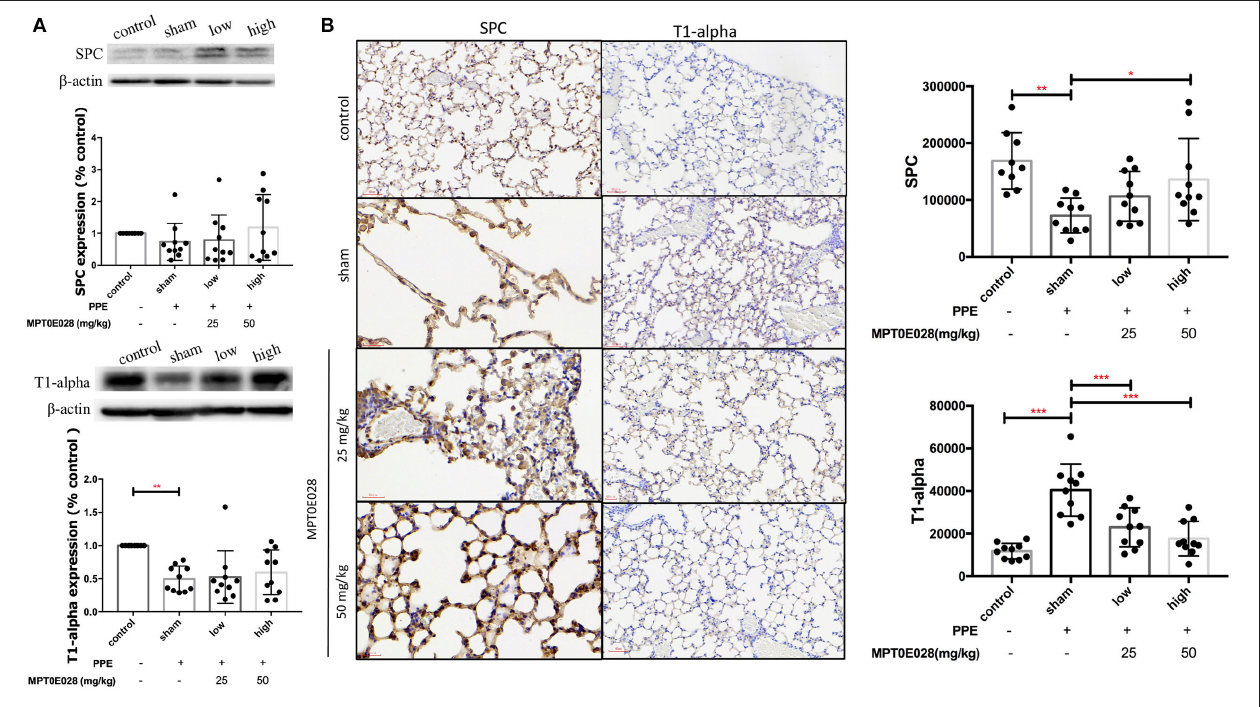
FIGURE 5 | Expressions of surfactant protein C (SPC) and T1 α in the lungs and alveolar region sby the MPT0E028 in mice with porcine pancreatic elastase (PPE)-induced emphysema. (A) Expressions of SPC and T1 α in whole lung lysates by the MPT0E028 at 0, 25, and 50 mg/kg body weight (BW) ( n = 10). (B) Expressions of SPC and T1 α in alveolar regions by IHC by the MPT0E028 at 0, 25, and 50 mg/kg BW ( n = 10) (magnification X20). * p < 0.05; ** p < 0.01; *** p < 0.001.